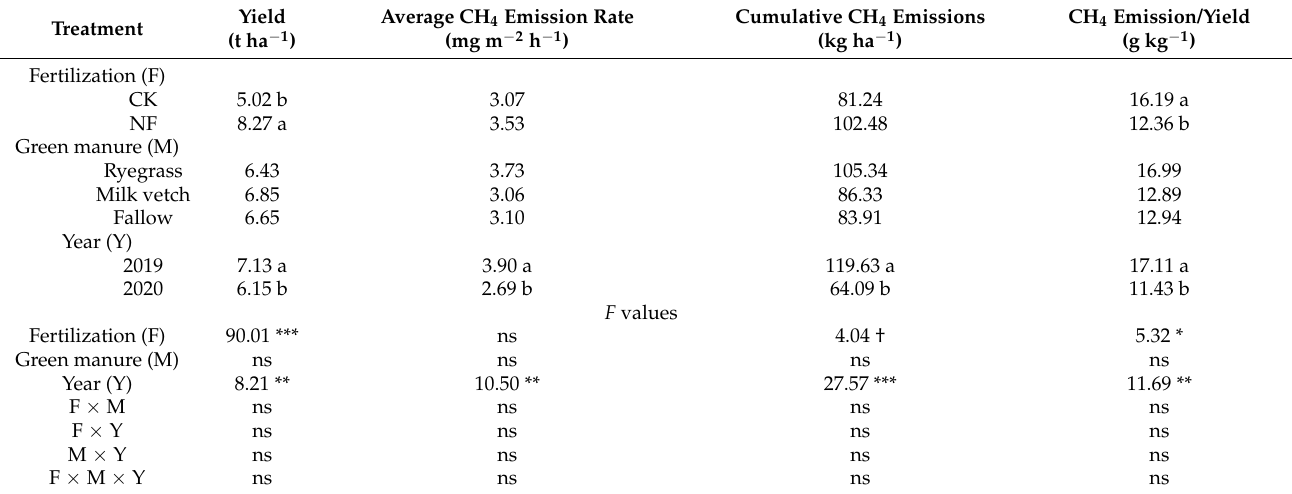
Table 4. Grain yields and CH 4 emissions under fertilization and green manure amendment.